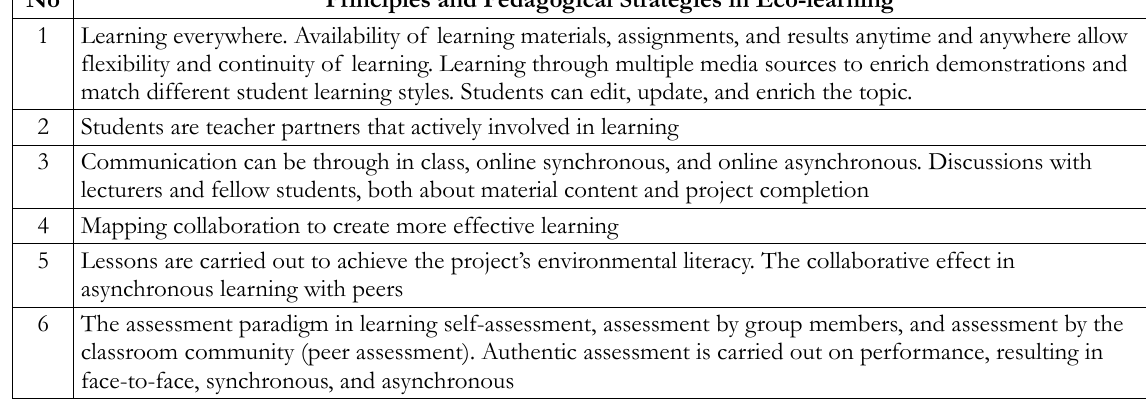
Table 1. Components of the Flipbook in Eco-Learning Learning